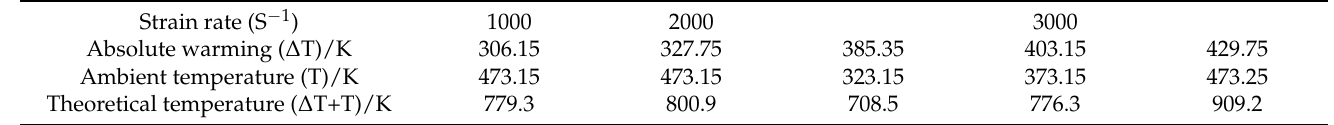
Table 6. Absolute temperature and theoretical temperature corresponding to each loading strain rate.